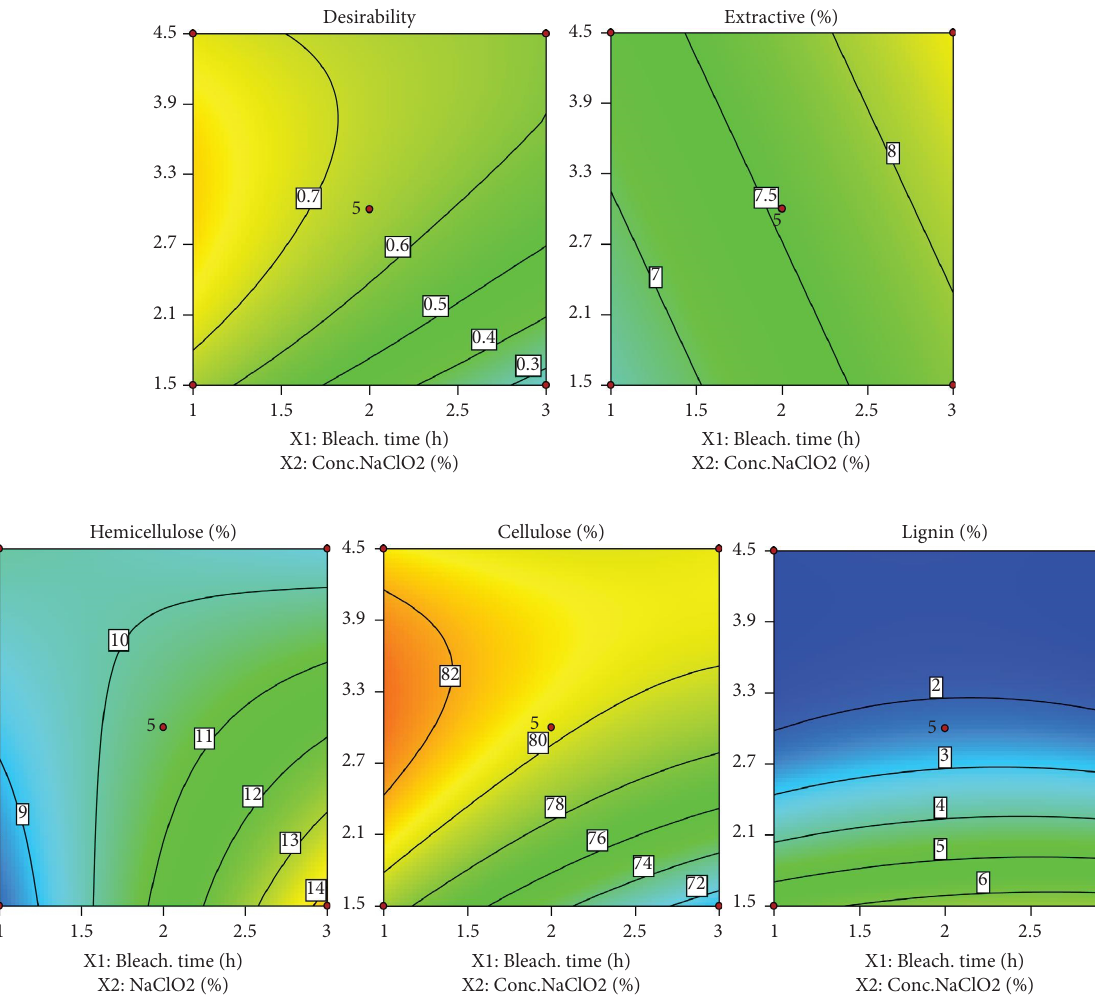
Figure 3: Point of optimization of process conditions and their parameters. Table 7: Confrmation of results at the optimization point on the response surface methodology.